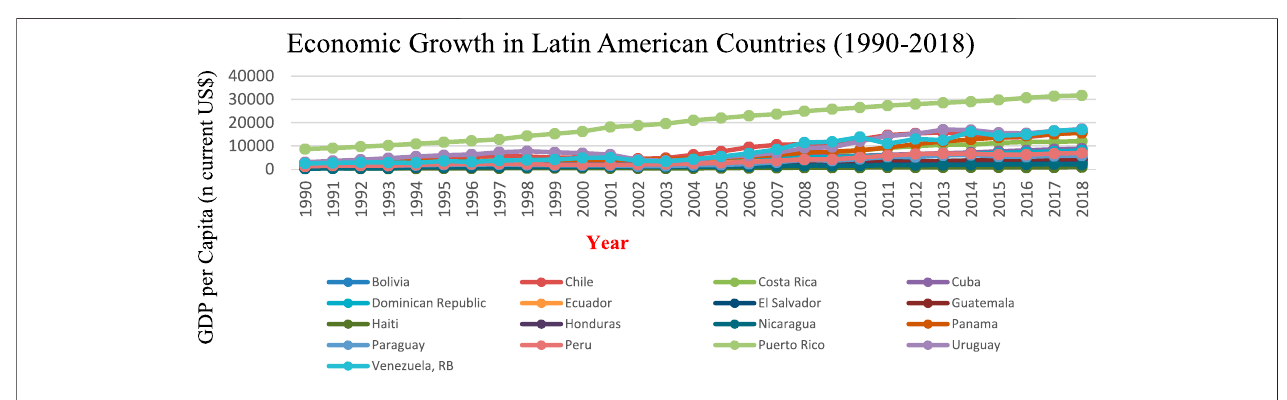
FIGURE 8 | Economic growth in Latin American